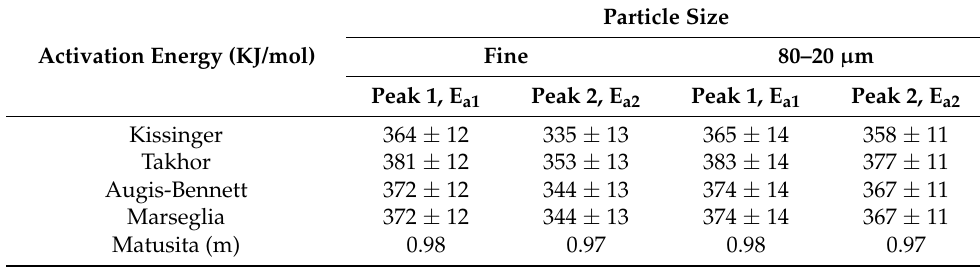
Table 5. Activation energies for 7.5B(Ba) glass.